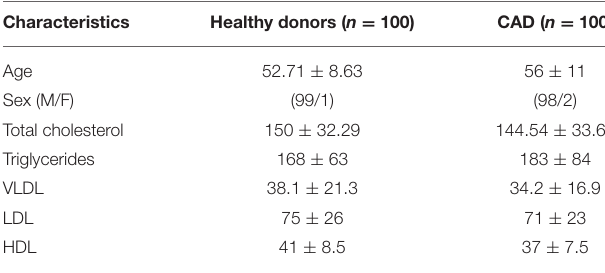
( Table 1 ). The mRNA expression of CD46, CD55 and CD59 did TABLE 2 | Demographic and clinical profile of healthy individuals and coronary artery disease